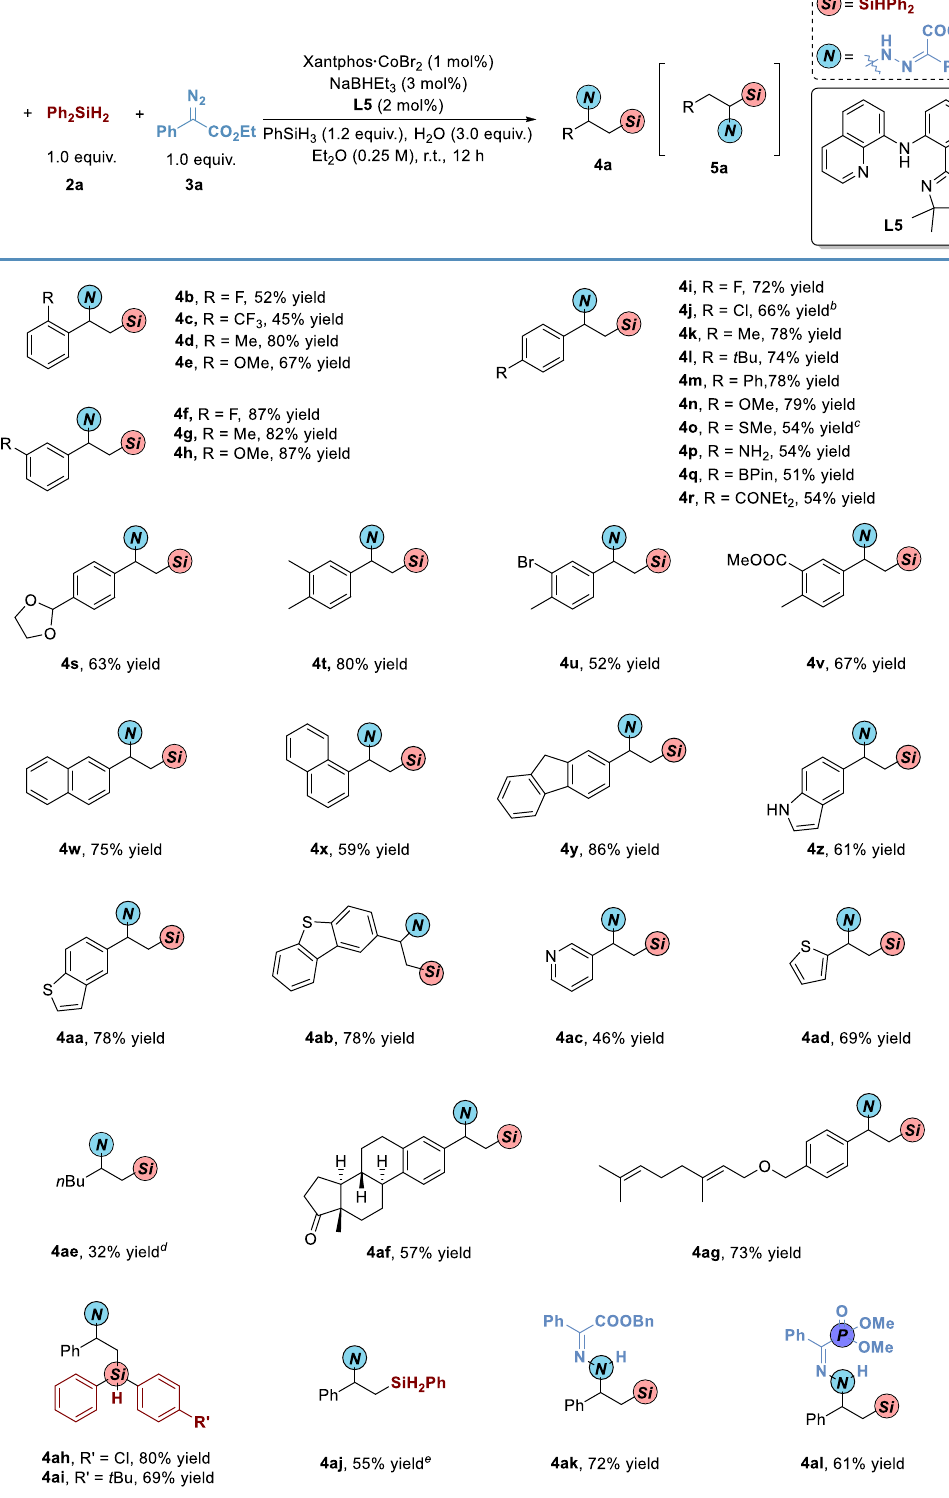
NATURE COMMUNICATIONS| (2022) 13:650